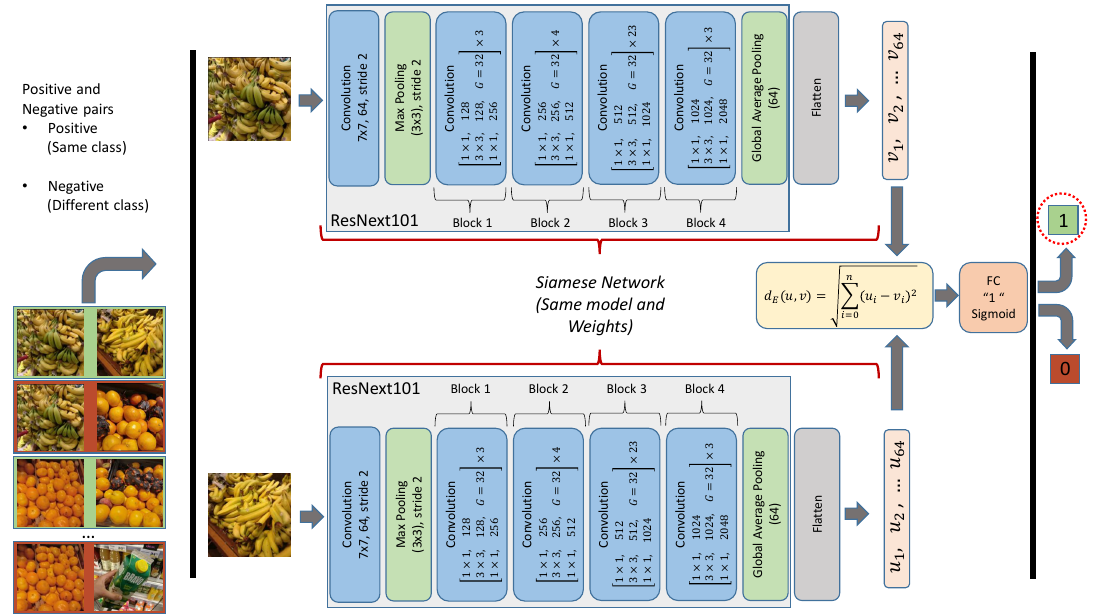
Figure 2. Category split to test the OSL problem.